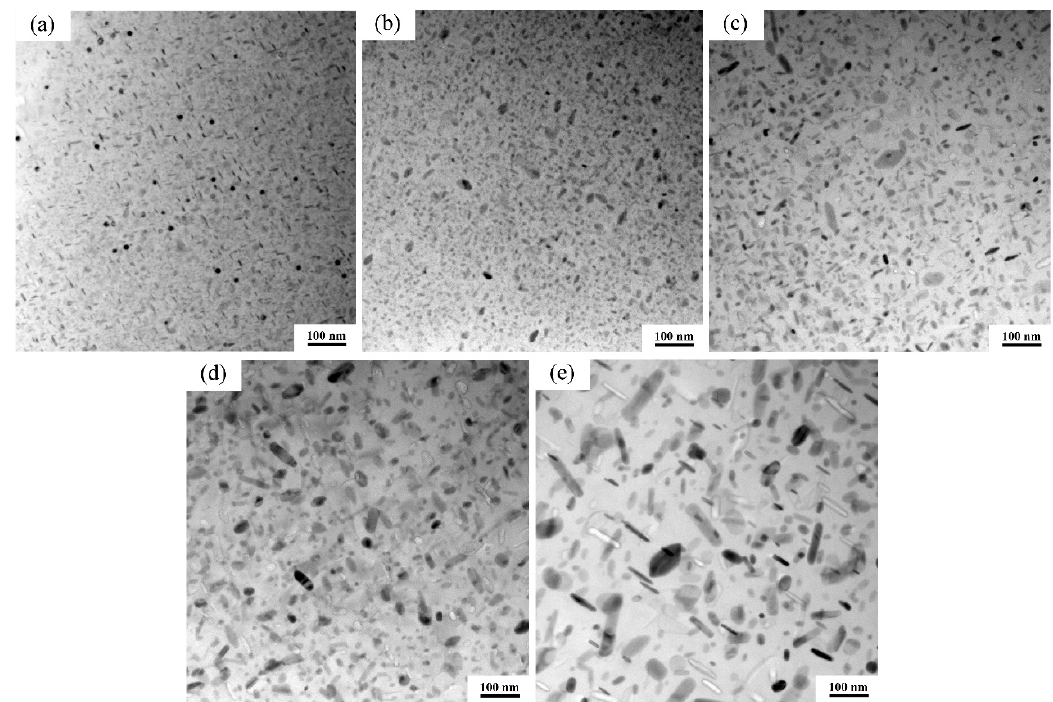
Figure 4. Bright-field TEM images of 7085 Al alloy plate after different heat treatment processes: ( a ) sample I (25 °C), ( b ) sample II (100 °C), ( c ) sample III (125 °C), ( d ) sample IV (150 °C), and ( e ) sample V (175 °C).